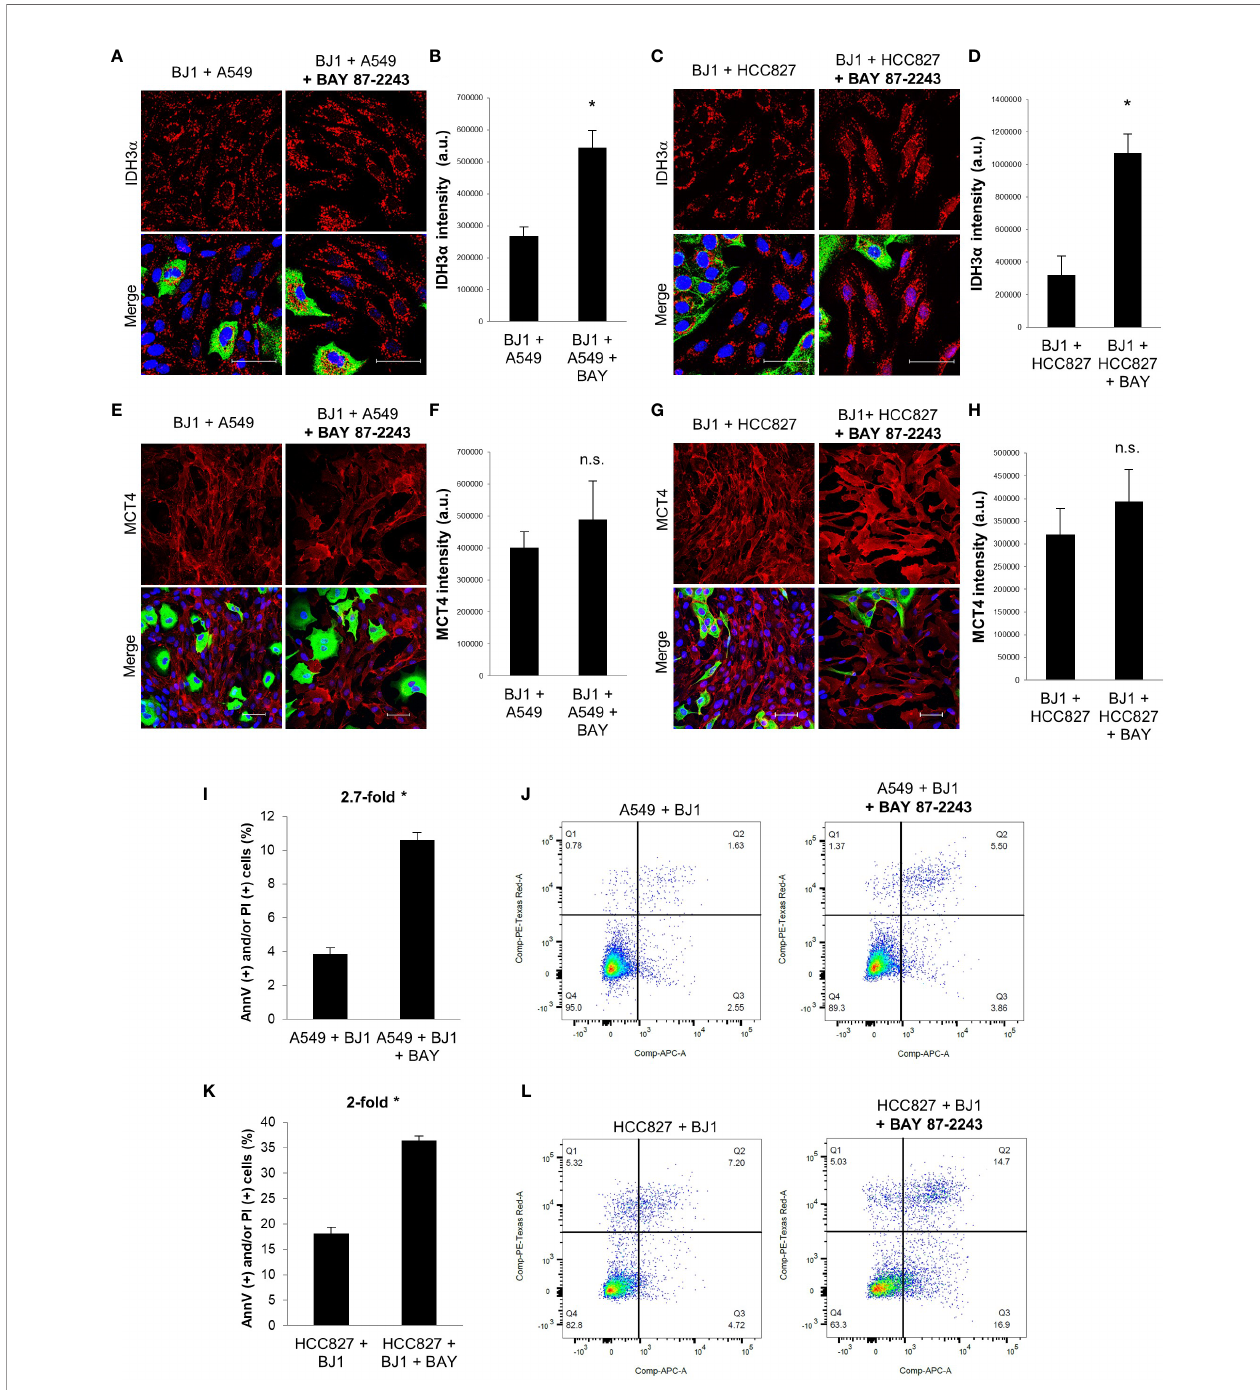
FIGURE 5 | Effects of HIF-1 a inhibition on fi broblast metabolism and carcinoma cell aggressiveness. Co-cultures of ADT carcinoma cells and BJ1 were treated with the HIF-1 a inhibitor BAY 87-2243 or vehicle control for 48 hours. (A – D) Confocal imaging of IDH3 a in co-cultures of BJ1 with A549 (A) and HCC827 (C) treated or untreated with BAY 87-2243, and their respective quanti fi cation of IDH3 a staining in BJ1 (B, D) . (E – H) Confocal imaging of MCT4 in co-cultures of BJ1 with A549 (E) and HCC827 (G) treated or untreated with BAY 87-2243, and their respective quanti fi cation of MCT4 staining in BJ1 fi broblasts (F, H) . Confocal microscopy images were acquired at the 40X magni fi cation, with 1.5x zoom in panels (A, C) . For all images, IDH3 a and MCT4 staining are shown in red, carcinoma cells are shown in green (K8/18 staining), and nuclei are shown in blue (DAPI). IDH3 a and MCT4 staining were quanti fi ed using ImageJ. (I – L) Flow cytometry assessment of percentage of carcinoma cells undergoing apoptosis (AnnV staining) and cell death (PI staining) in co-cultured A549 (I, J) and HCC827 (K, L) untreated or treated with BAY 87-2243 with representative fl ow cytometry plots showing gating strategy for AnnV (APC) and PI (PE) staining. Student ’ s t-test was used for statistical analyses (*p<0.05). (a.u., arbitrary units. Scale bar = 50 m